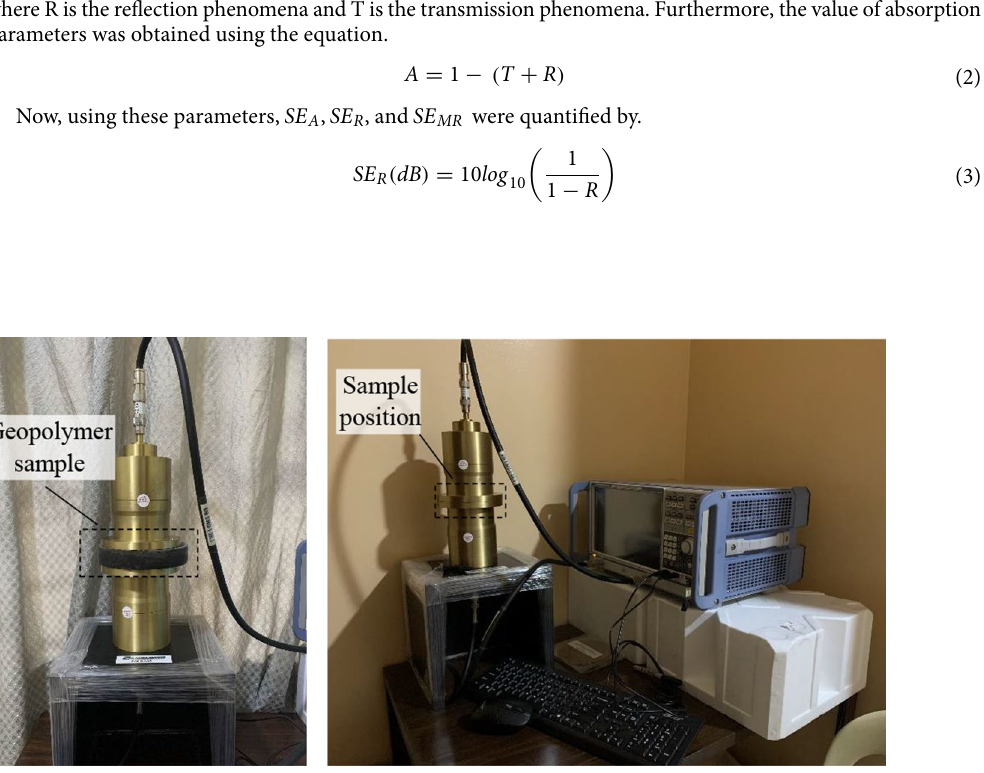
Figure 3. EMI-SE experimental